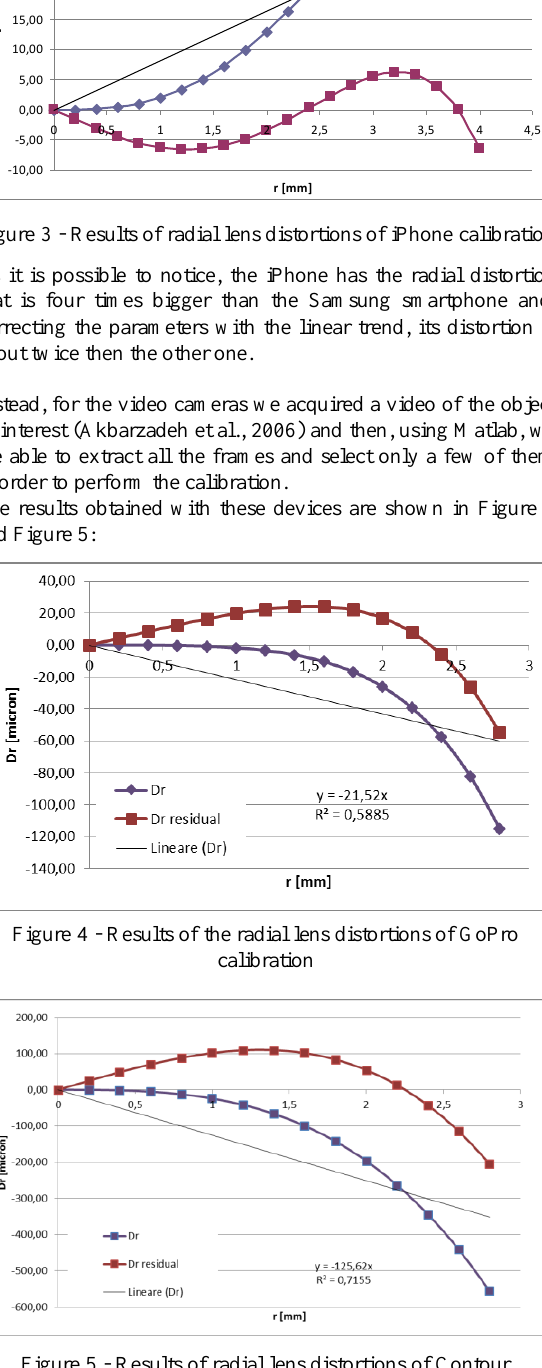
Figure 5 - Results of radial lens distortions of Contour calibration